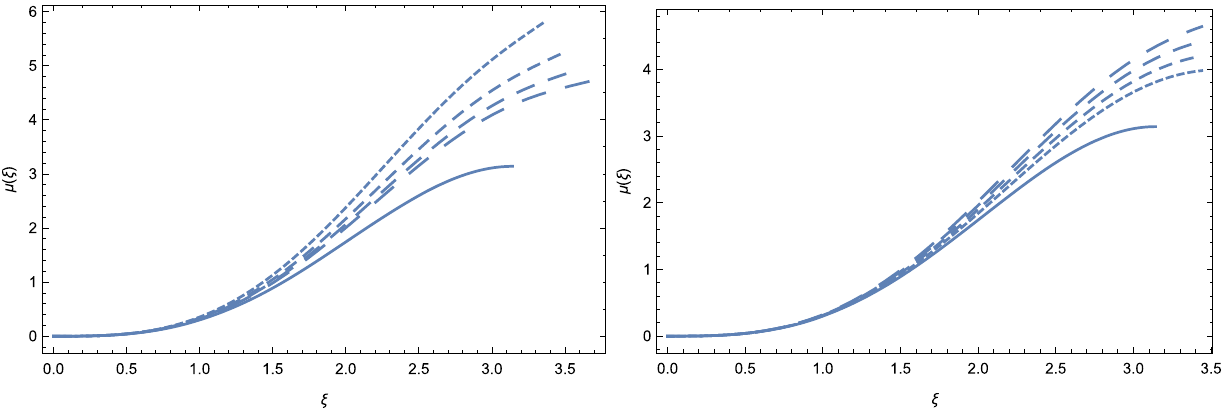
Fig. 2 Variation of the dimensionless mass μ(ξ) as a function of the dimensionless radial distance ξ , for different model parameters. In the left Figure, θ = 0 . 01, γ = 2, (cid:2) = 0 . 3, ρ bc /ρ c = 0 . 2, while σ = 0 . 01 (dotted curve), σ = 0 . 015 (short dashed curve), σ = 0 . 02 (dashed curve), and σ = 0 . 025 (long dashed curve), respectively. In the right